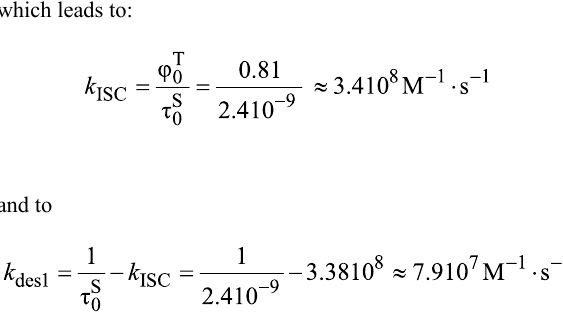
equal to the initial ground state RB concentration, i.e.,